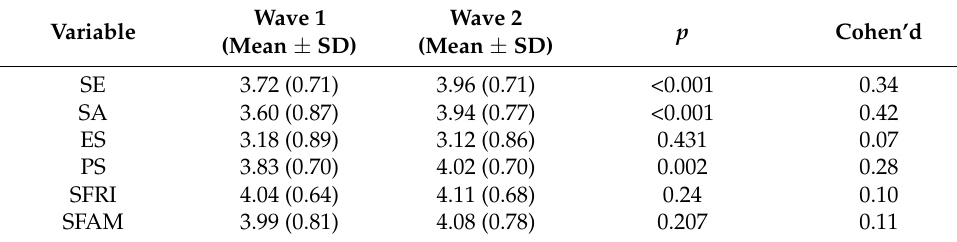
Table 1. The descriptive statistic and paired t -test among wave 1 and wave 2.